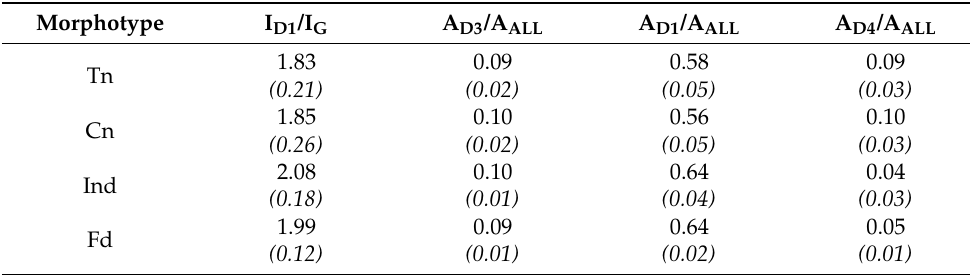
Table 7. Raman spectral ratios for the studied morphotypes.